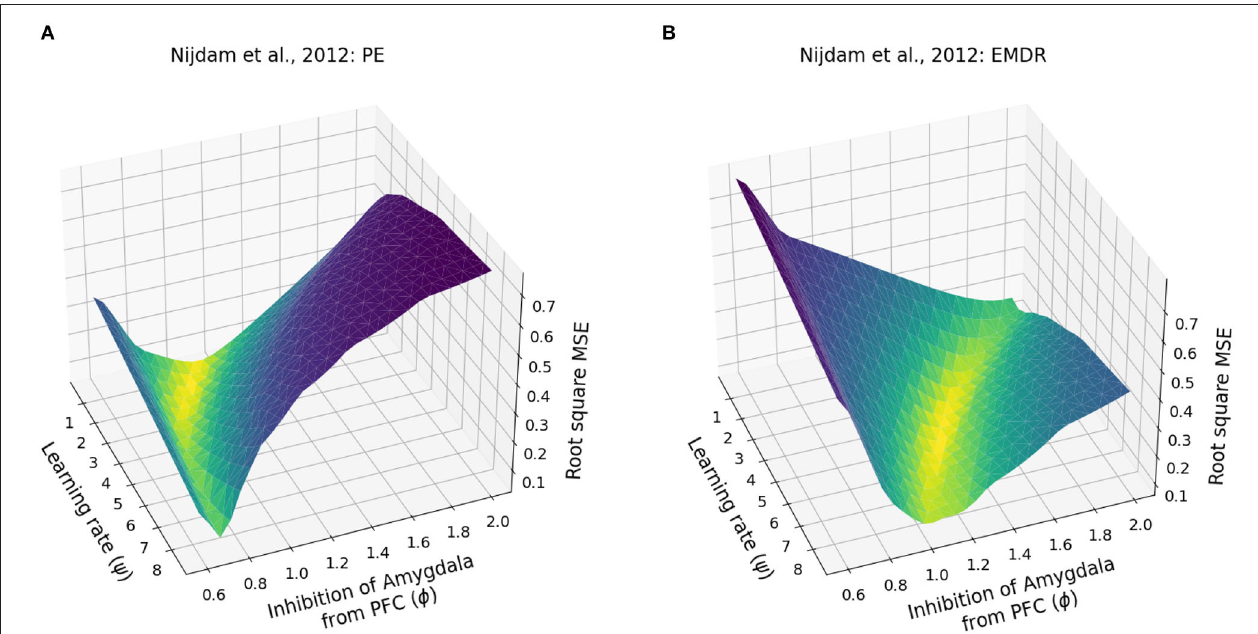
FIGURE 7 | Patients data fitting. (A) Root square MSE for the fitting of the PE data from Nijdam et al. (2012). (B) Root square MSE for the fitting of the EMDR data from Nijdam et al. (2012).